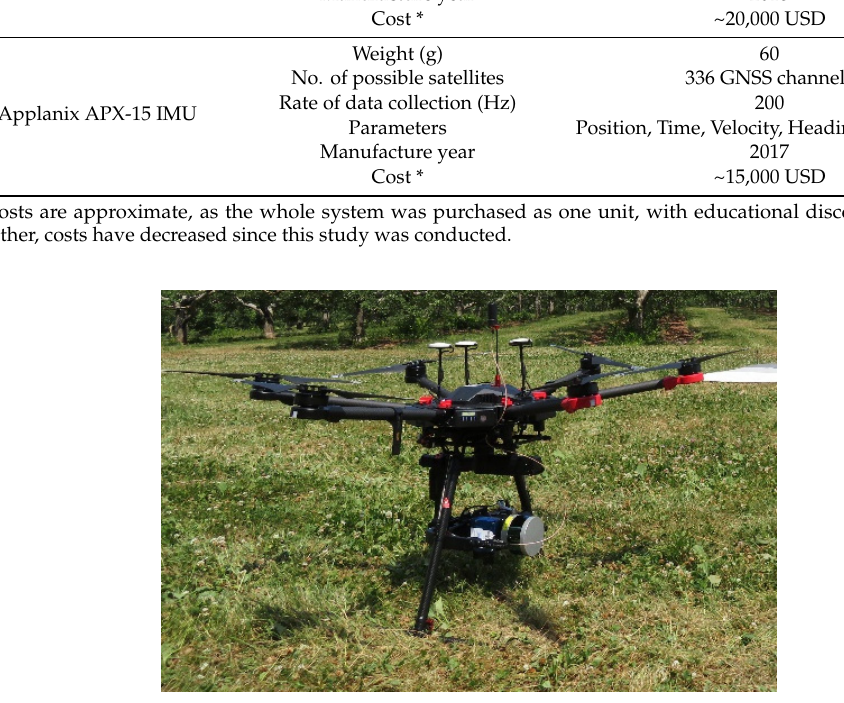
Figure 3. Image of DJI Matrice 600 Pro with Velodyne Puck mounted and pointed at nadir. Table 2. Locations of checkpoints (CPs) in decimal degrees, altitude (m) of each checkpoint, and differences between LiDAR DSMs and checkpoints in meters (m). Overall Mean Error (ME), Standard Deviation of Error (St. Dev.), Mean Average Error (MAE), and RMSE also listed.